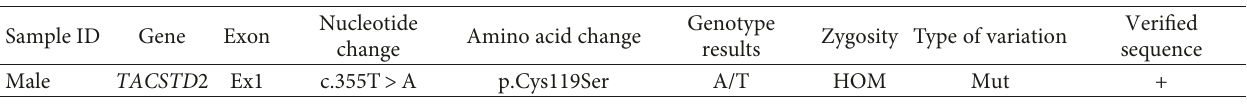
Figure 1: Clinical photograph of preoperative and postoperative appearance of both eyes of the GDLD cornea of the patient. (a) Slit-lamp photograph of the right cornea showing grayish-white multiple superficial corneal nodules of various sizes; (b) slit-lamp photograph of right eye showing clear cornea after surgery; (c) slit-lamp photograph of the left cornea showing dense grayish-white multiple superficial corneal nodules of various sizes; (d) slit-lamp photograph of left eye showing clear cornea after Table 1: Genetic analysis of GLCD. DNA sequence variation that occurs in at least 1% population and is nonpathogenic; DNA sequence variation that is pathogenic or possibly pathogenic.